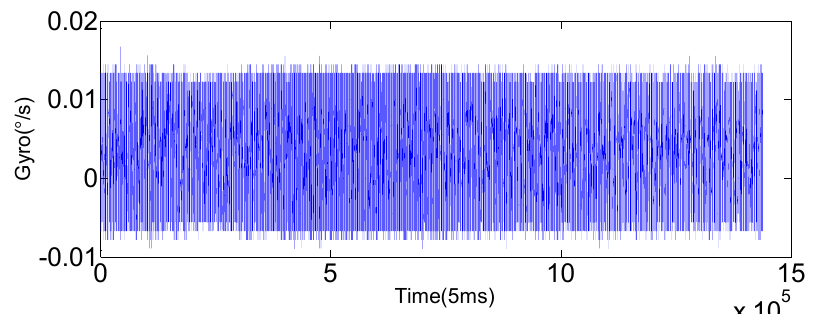
Figure 6. Experimental setup of FOG.